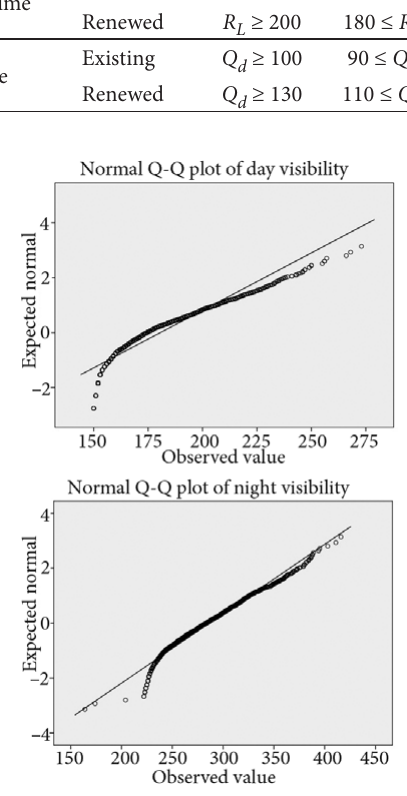
Fig. 3. Q-Q plots for daytime and night-time